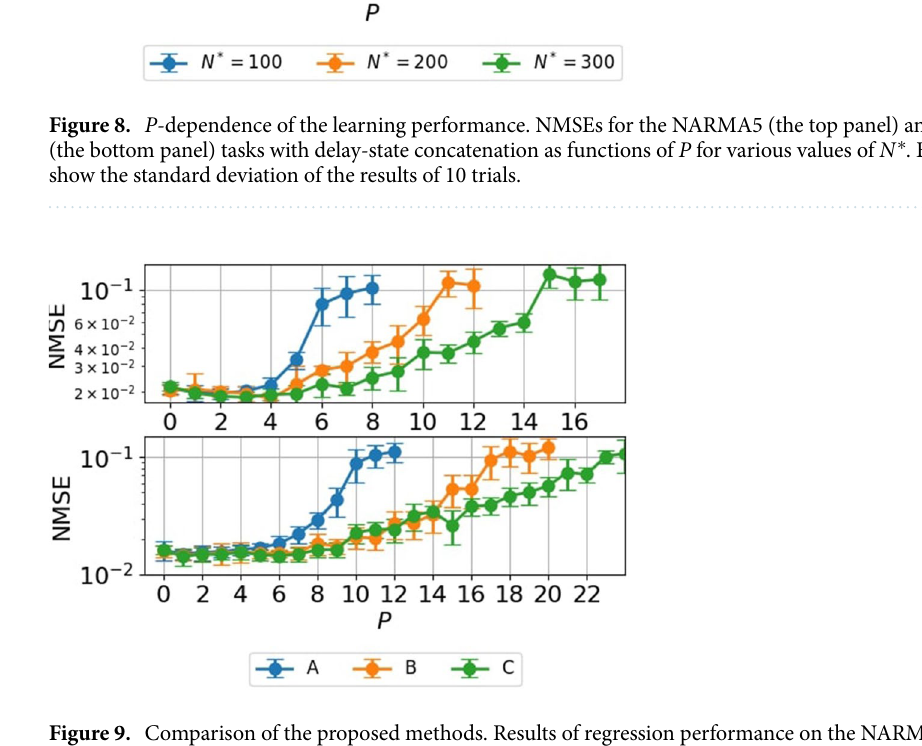
Figure 9. Comparison of the proposed methods. Results of regression performance on the NARMA10 task for various values of P with N ∗ = 200 (the top panel) and N ∗ = 300 (the bottom panel) for ( A ) delay-state concatenation, ( B ) delay-state concatenation with one transient state, and ( C ) drift-state concatenation. Error bars show the standard deviation of the results of 10